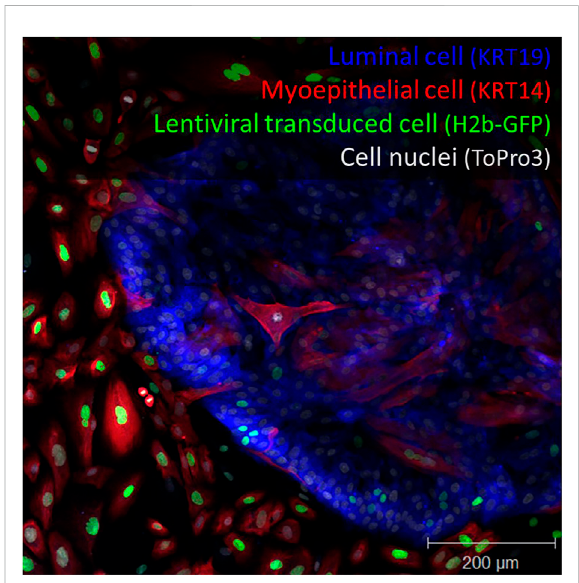
FIGURE 1 Lentiviral transduction bias.Primarybreastculture containing luminalcells(keratin19 + ,blue),myoepithelialcells(keratin14 + ,red) transduced with a histone 2-beta GFP encoded lentivirus (H2b- GFP, green). Staining reveals imbalanced cell transduction with respect to cell type. Nuclei are counterstained with ToPro3 dye. Scale = 200 μ